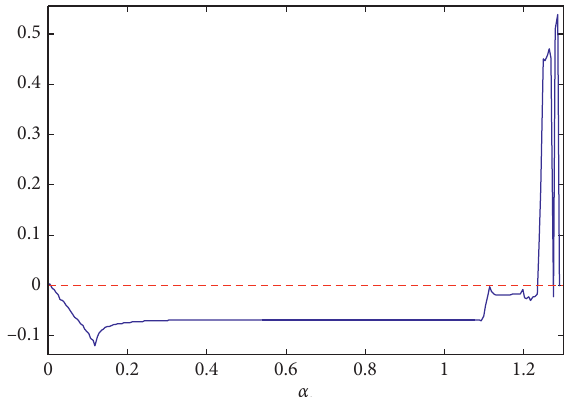
Figure 2: Maximal Lyapunov exponent for α